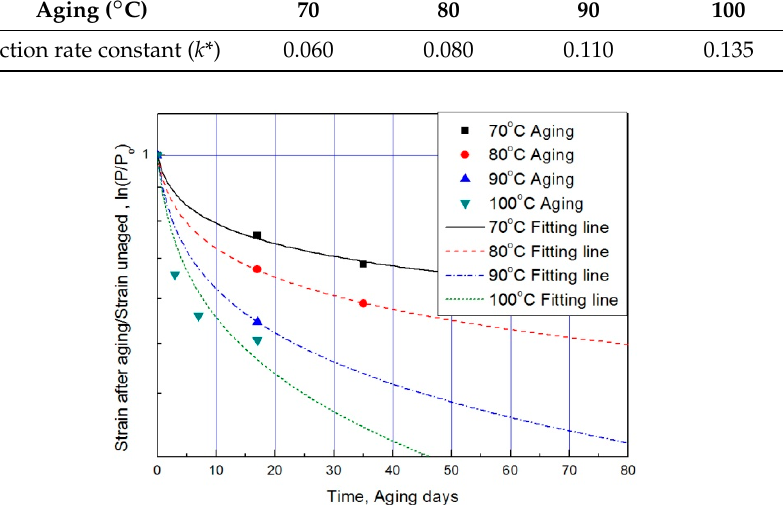
Figure 10. Modified characteristic equation according to aging time by temperature.